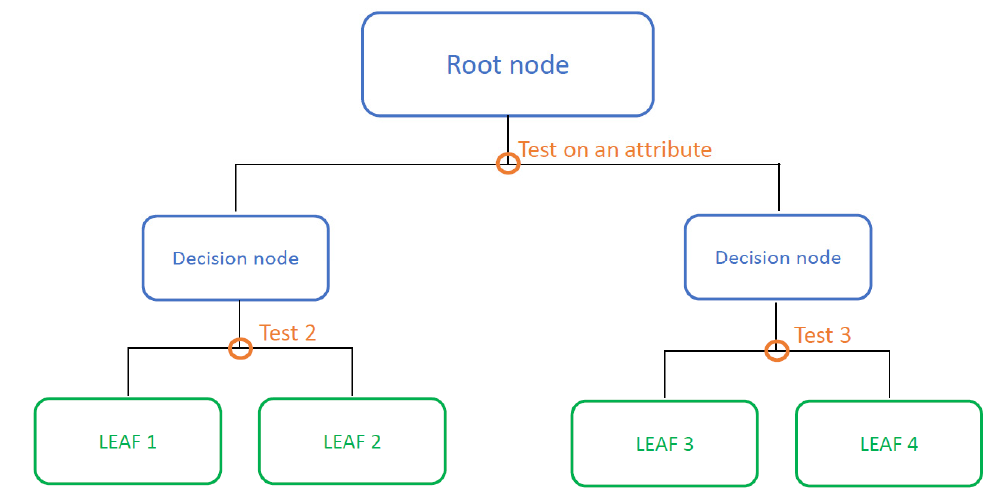
Figure 2. Representation of a general binary decision tree.